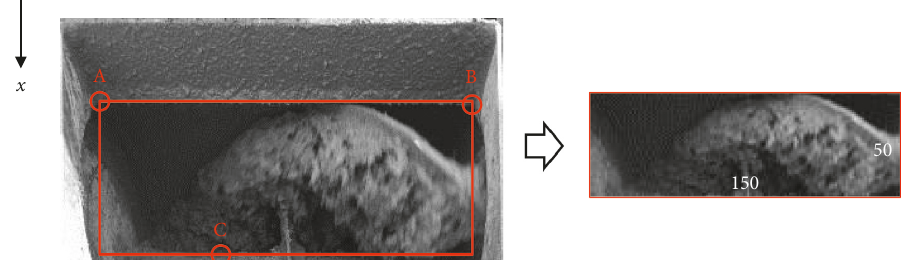
Figure 9: Extracting the ROI.